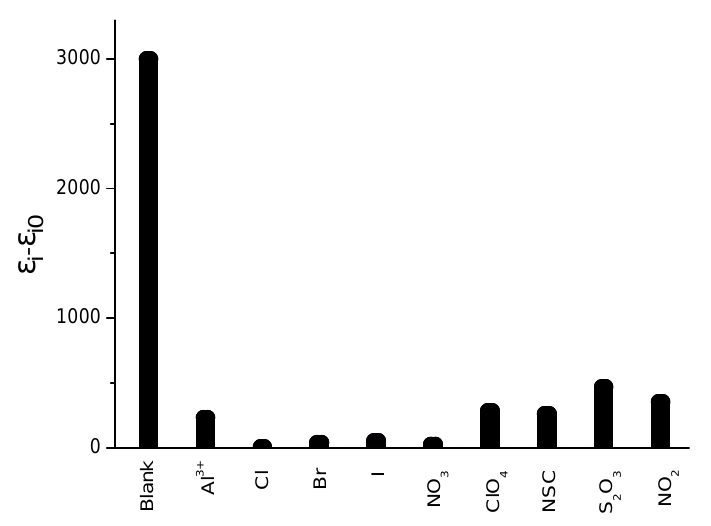
O = 6:4, 2 was the absorption intensity at i0 was the absorption intensity i Al 3+